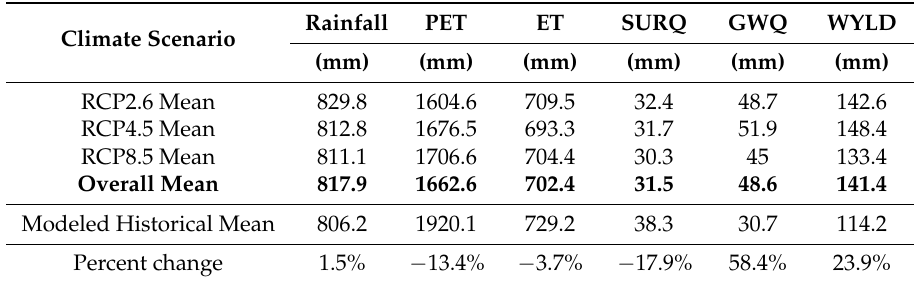
Table 4. Average annual rainfall, potential evapotranspiration (PET), evapotranspiration (ET), surface runoff (SURQ), groundwater flow to stream (GWQ), and water yield (WYLD) under historical (1985–2010) and future climate (2016–2040). Water yield is the net amount of water entering the stream from each hydrologic response unit, groundwater flow and surface runoff.